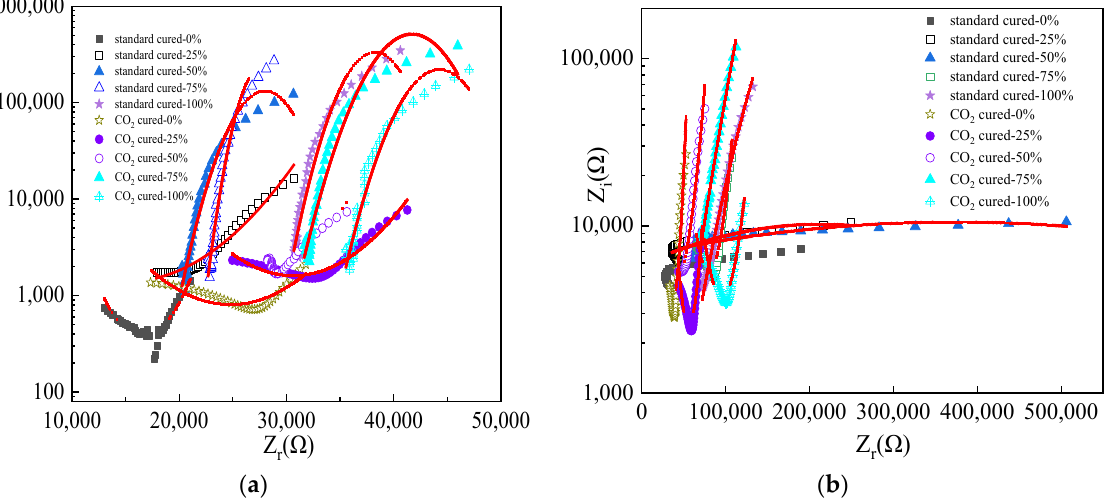
Figure 9. The AC impedance spectrum curves of reinforced alkali-activated mineral admixtures during D–W alternations. ( a ) Before NaCl corrosion. ( b ) After 20 NaCl D–W alternations. All values of the AC impedance spectrum curves were input to ZSimpWin software and the fitting curves of the equivalent circuit diagrams were obtained (the red lines in Figure 9). Additionally, the equivalent circuit diagram of reinforced alkali-activated mineral